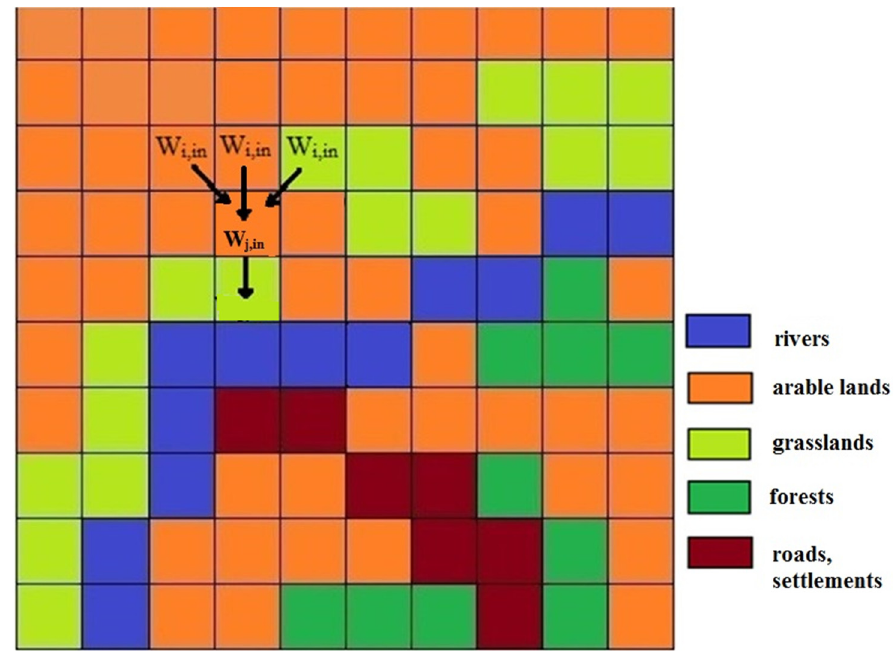
Figure 2. Schematic diagram of sediment balance assessment in a specific cell of the raster .